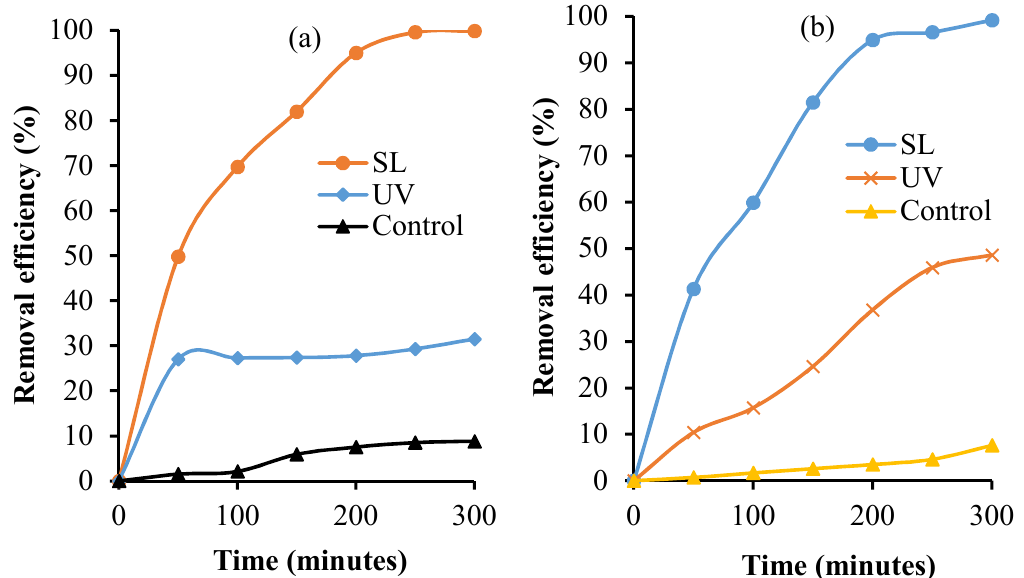
Figure10. Photodegradationprofilesof( a )MOand( b )GYundersunlight(SL)andstrictultraviolet-light Figure 10. Photodegradation profiles of ( a ) MO and ( b ) GY under sunlight (SL) and strict ultraviolet- (UV) irradiation, using the 2%C-TiO 2 -CFA / PAN membrane photocatalyst at pH 3.5. light (UV) irradiation, using the 2%C-TiO 2 -CFA/PAN membrane photocatalyst at pH 3.5.